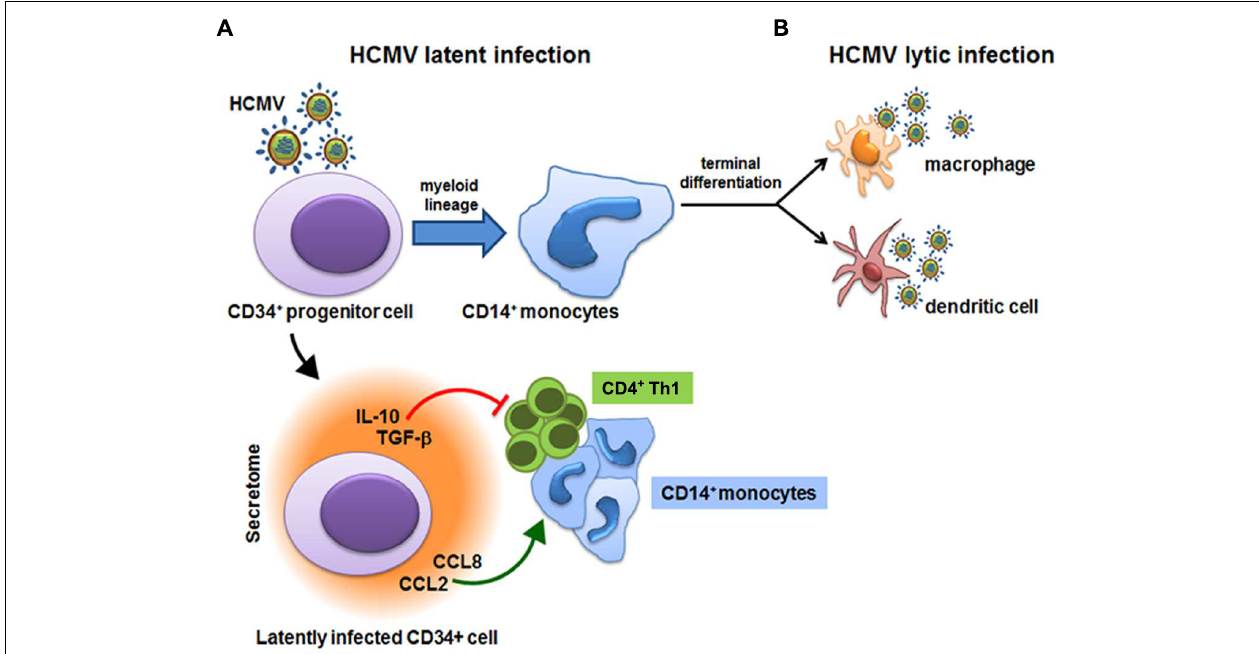
FIGURE 3 | Human cytomegalovirus (HCMV)-derived secretome and virus latency. HCMV latency is established in bone marrow cells and is carried out in CD34 + hematopoietic progenitor cells and in CD14 + monocytes. (A) Latently infected CD34 + cells secrete CCL2/MCP-1 and CCL8/MCP-2 cytokines that recruit CD14 + monocytes and CD4 + Th1 cells to latently infected cells. However, the secretion of highly immunosuppressive cellular IL-10 and TGF- β inhibit proliferation and the antiviral functions of CD4 + Th1 cells. (B) Upon differentiation of CD14 + monocytes into mature macrophages or dendritic cells, reactivation of HCMV IE gene expression is promoted and the viral lytic gene program is